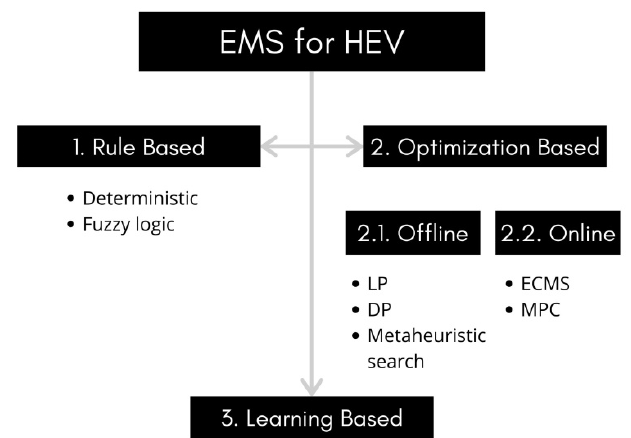
Figure 2. EMS classification. (DP—dynamic programming, LP—linear programming, ECMS— equivalent consumption minimization strategy, MPC—model predictive control).